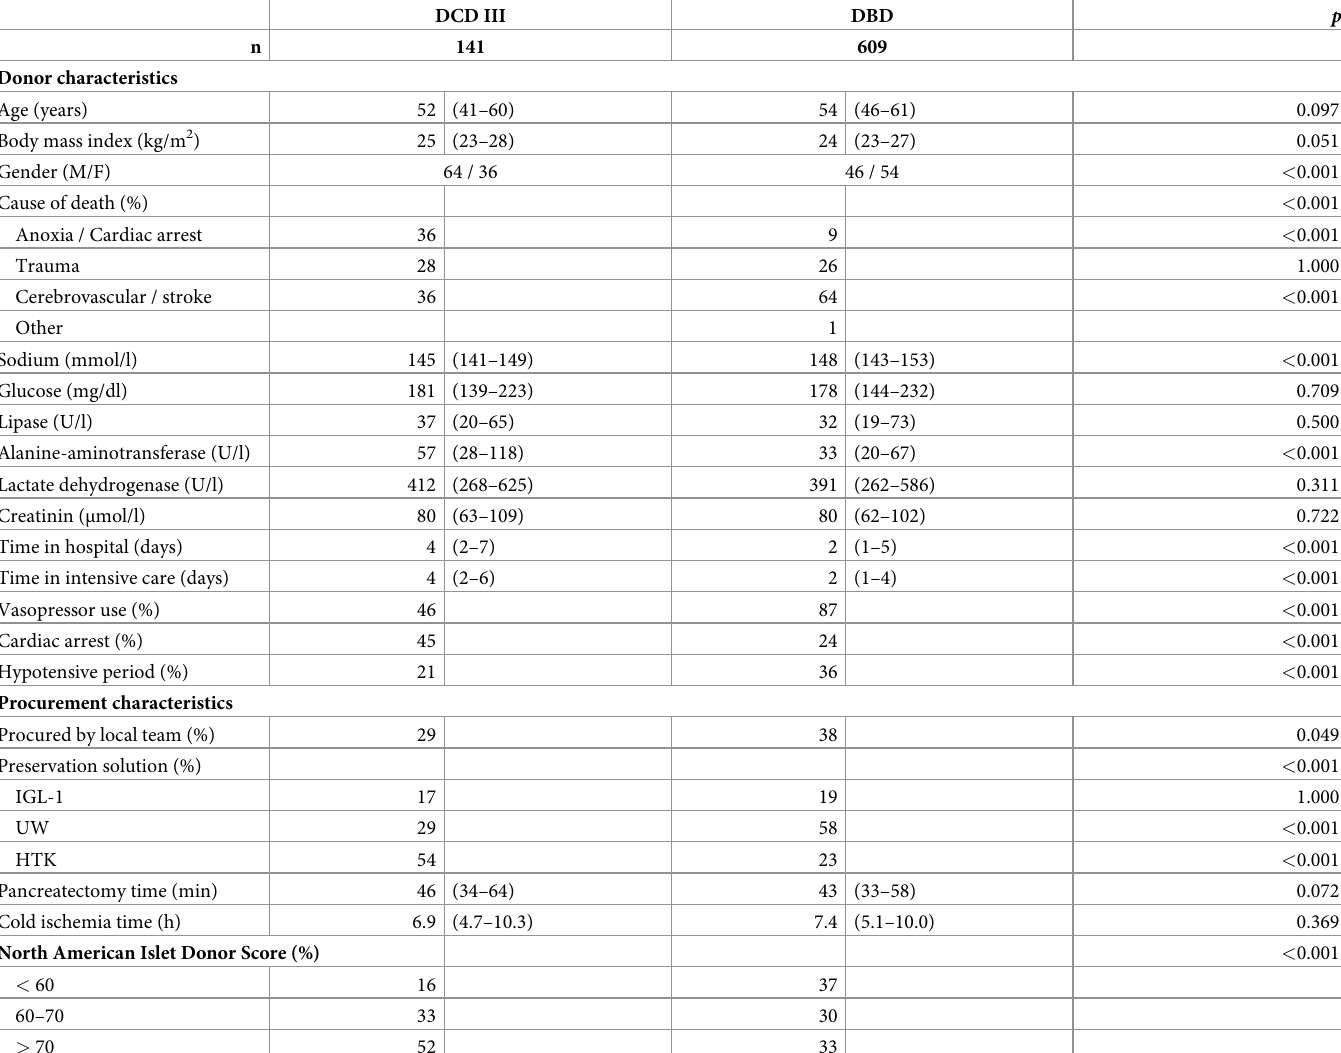
Table 1. Donor and organ procurement characteristics.